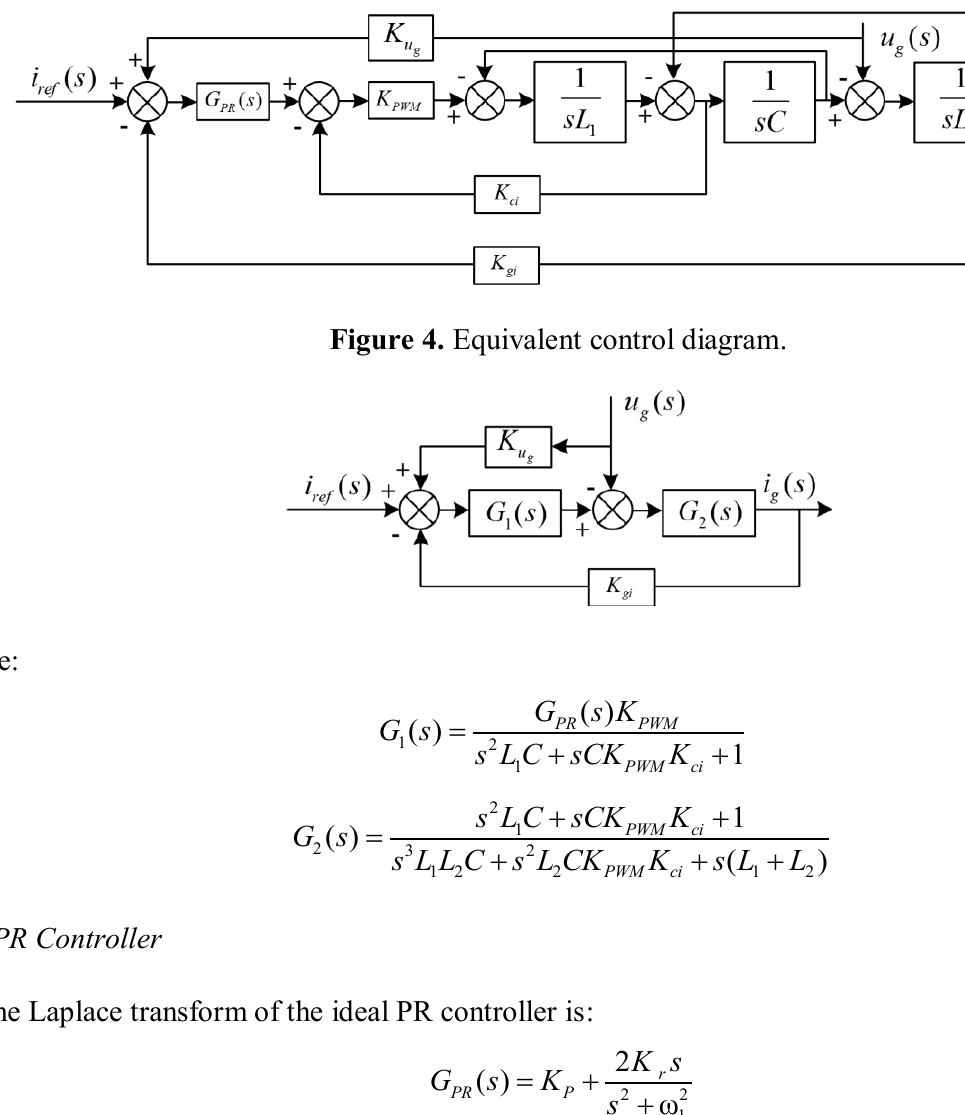
Figure 3. Injected current: control diagram.